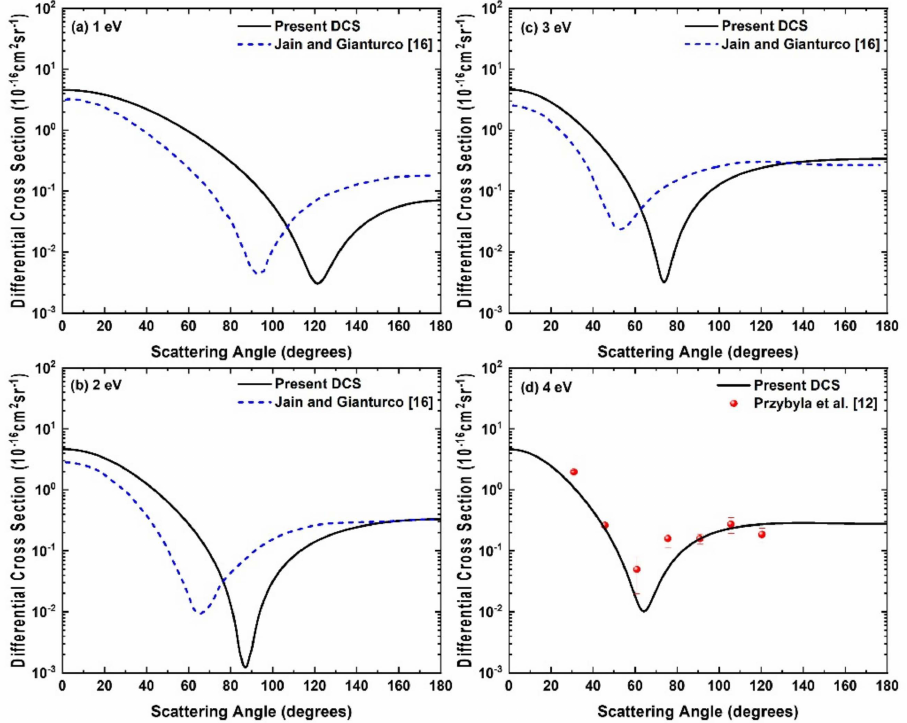
Figure 1. Differential cross sections for positron-CH 4 elastic scattering at incident positron energies ( a ) 1 eV, ( b ) 2 eV, ( c ) 3 eV and ( d ) 4 eV. Solid line, present DCS; dashed line, Jain and Gianturco [16]; solid sphere with error bars, Przybyla et al.